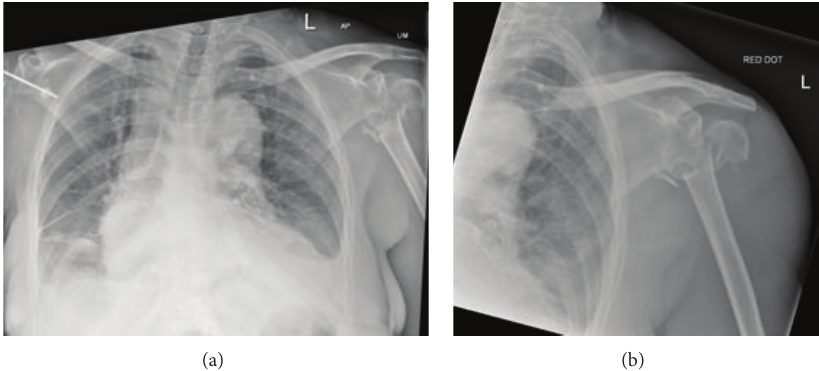
Figure 4: AP radiographs of the left shoulder showing a proximal humeral fracture (a,